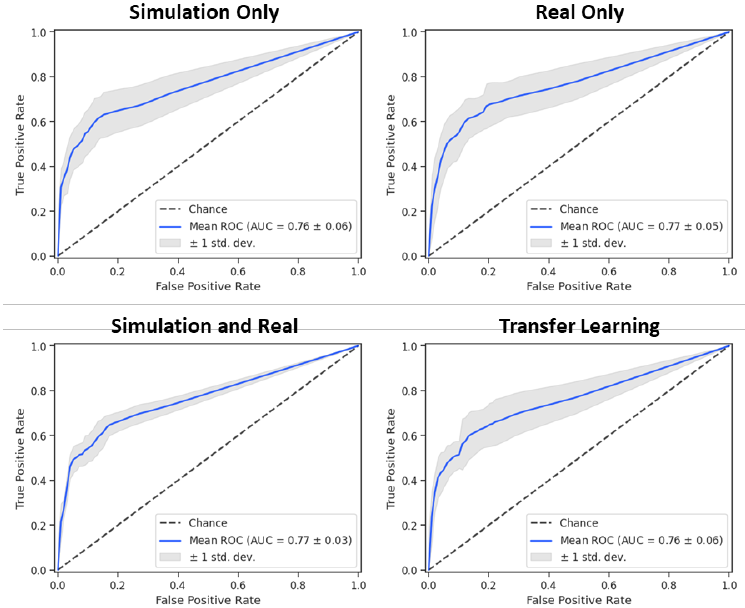
Figure 5. Receiver operating curves for networks trained using synthetic data, real data, combinations of the two, and transfer learning. The mean and standard deviation for the five K-fold networks are shown in blue and gray, respectively. All four training cases are shown to be very similar.